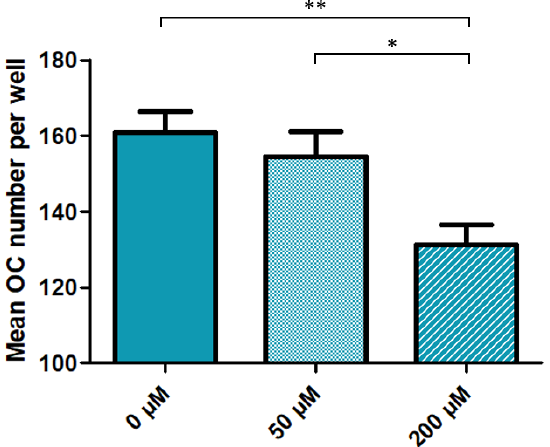
Figure 1. Impact of cysteamine treatment on osteoclast differentiation in patients with nephropathic cystinosis. Osteoclasts (TRAP-positive cells with over three nuclei) were generated from PBMCs of NC patients and treated with increasing doses of cysteamine (untreated, 50 and 200 µM). Results in terms of osteoclasts number are presented as means for seven to eight wells, with SEM. A total of 13 patients were included in the analysis, as results of cell cultures were not satisfactory for the remaining four patients. OC, osteoclasts; TRAP, Tartrate-Resistant Acid Phosphatase; PBMC, Peripheral Blood Mononuclear Cells; SEM, Standard Error of the Mean. * p < 0.05, and ** p < 0.01 compared between indicated groups by Anova followed by Bonferroni. Table 4. Osteoclastic differentiation outcomes in each patient.